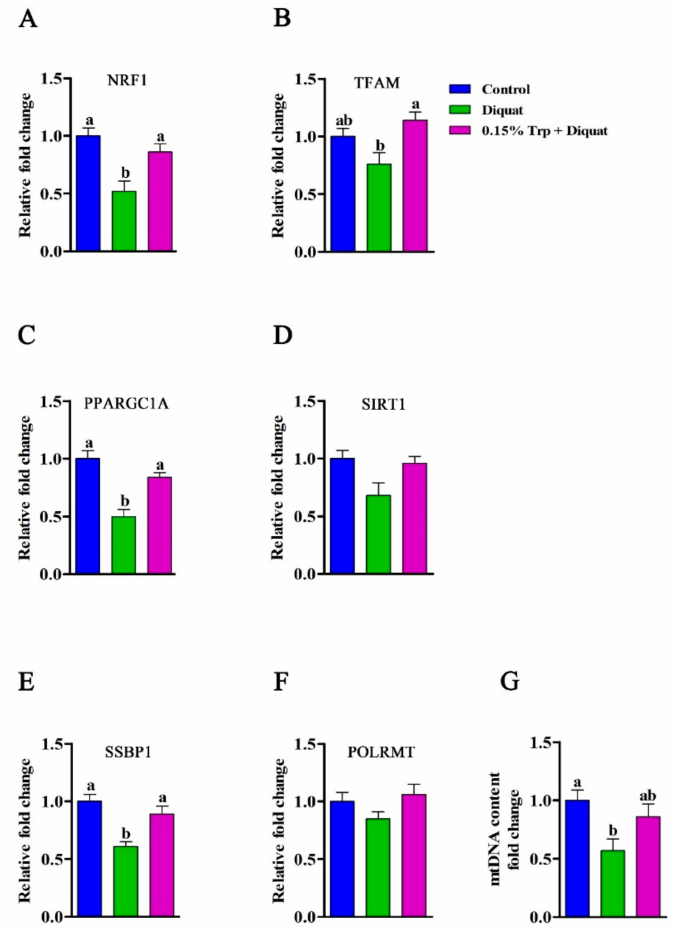
Figure 8. E ff ects of dietary tryptophan supplementation on mRNA expression of genes involved in mitochondrial biogenesis and mtDNA content in the jejunum of piglets challenged with diquat. ( A ) NRF1 , nuclear respiratory factor 1; ( B ) TFAM , transcription factor A, mitochondrial; ( C ) PPARGC1A , peroxisome proliferative activated receptor gamma coactivator 1 alpha; ( D ) SIRT1 , sirtuin 1; ( E ) SSBP1 , single stranded DNA binding protein 1; ( F ) POLRMT , DNA-directed RNA polymerase, mitochondrial; ( G ) mtDNA, mitochondrial DNA. Data are means ± standard error; n = 8 for each group. Mean values sharing di ff erent superscripts within the same row di ff er significantly ( p < 0.05). Control, piglets